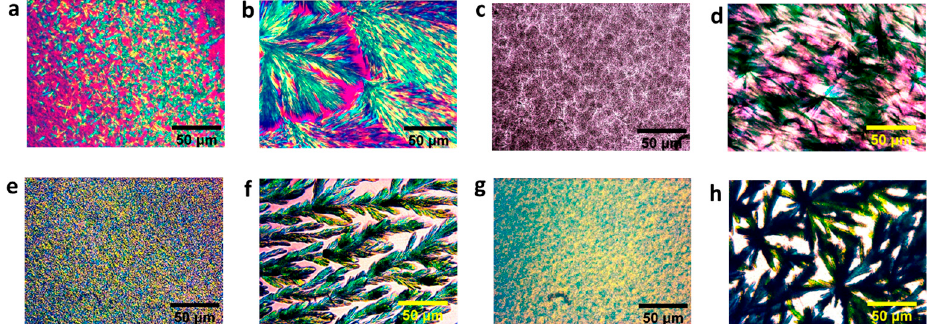
Figure 3. Polarizing optical micrographs at room temperature: 5 wt% DIBA in hexylbenzene